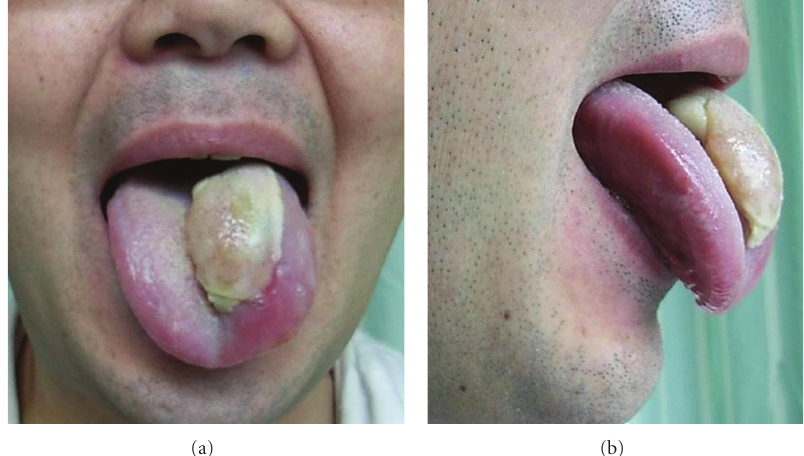
Figure 4: At 7 days after the operation, a photograph showing tongue swelling on the left side because of compression by the bite